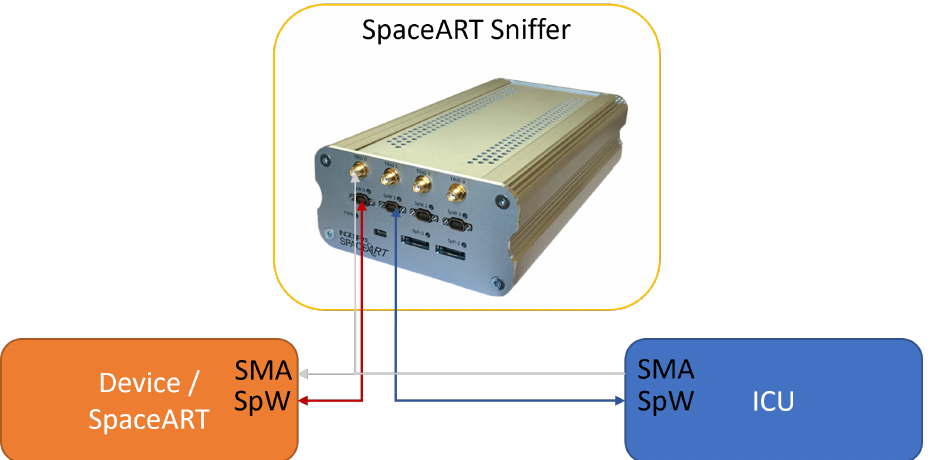
Figure 7. SpaceART SpW Sniffer is used to unobtrusively monitor the SpW connection between the emulated device and the